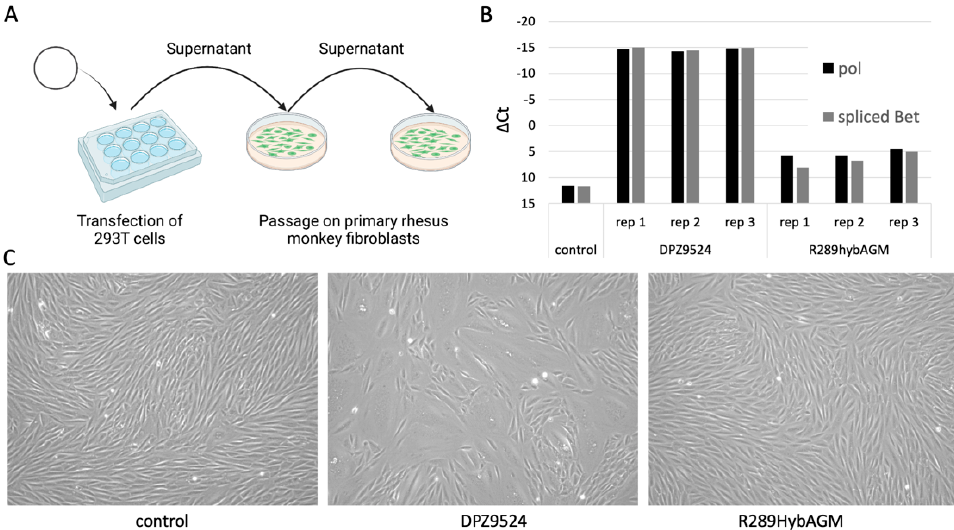
Figure 1. The pSFVmmu-DPZ9524_1 infectious clone yields infectious foamy virus. ( A ) After transfection of pSFVmmu-DPZ9524_1 or a proviral clone of R289hybAGM into 293T cells, cell-free supernatant from transfected cells or untransfected cells (control) was transferred to primary rhesus monkey fibroblasts. (Schematics created with BioRender.com.) ( B ) Expression of viral RNA (pol and spliced Bet mRNA) in primary rhesus monkey fibroblasts. ∆ Ct = Ct viral transcript − Ct HPRT . Ct was set to 40 cycles for negative samples (control). Values for three biological replicates (rep 1–3) and one control using supernatant from untransfected 293T cells are shown. ( C ) Representative phase contrast images of primary rhesus monkey fibroblasts after inoculation with the respective plasmid-derived foamy virus.